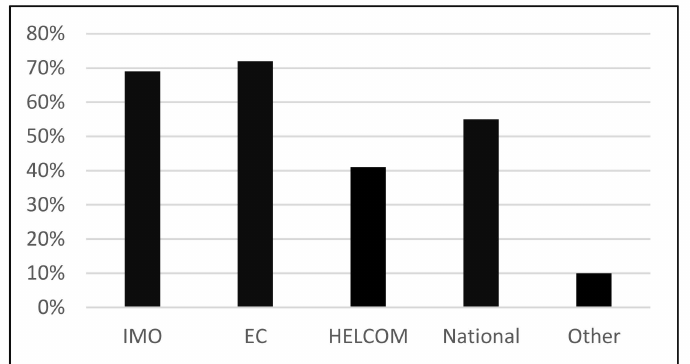
Figure 3. Sources of research